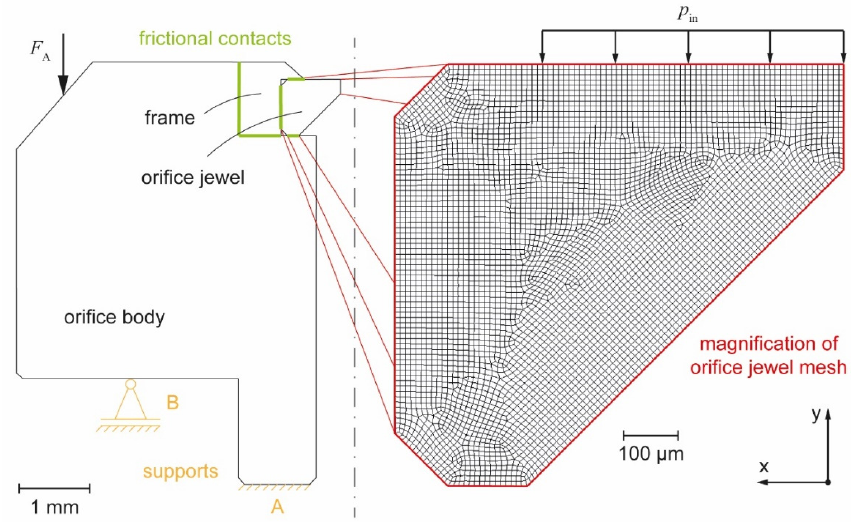
Figure 3. Boundary conditions for FEM simulation of the orifice assembly: the magnification shows the meshed sapphire orifice jewel; the first step was to apply the mounting force F a on the orifice body chamfer before the operating pressure pin on the sapphire was applied in the second step.